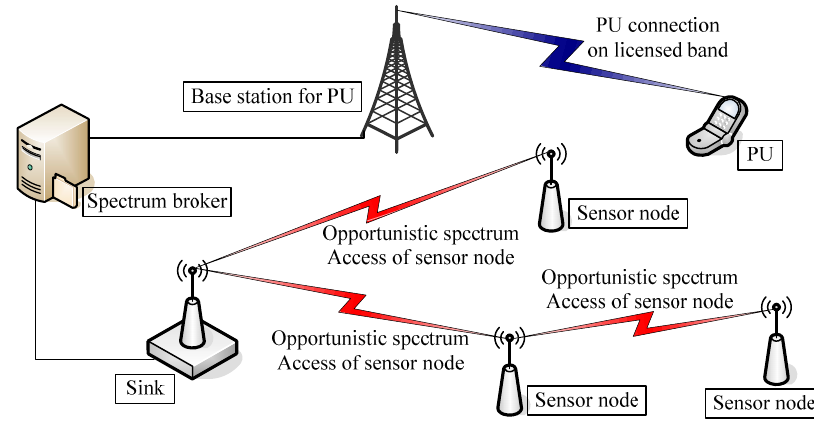
Figure 1. A simple cognitive radio wireless sensor network (CR-WSN) model.